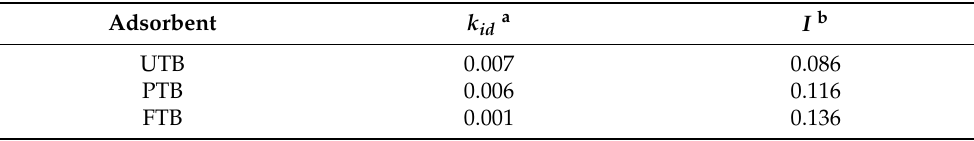
Table 3. Intra particle diffusion kinetic model of untreated sugarcane bagasse (UTB), alkali and ionic liquid pretreated sugarcane bagasse (PTB), and fermented sugarcane bagasse (FTB). Adsorbent k id a I b UTB 0.007 0.086 PTB 0.006